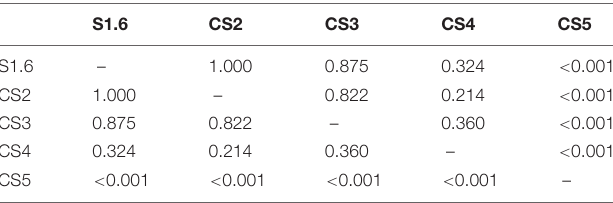
TABLE 2 | Pairwise comparison between different AF scan image quality evaluation groups ( p -value).